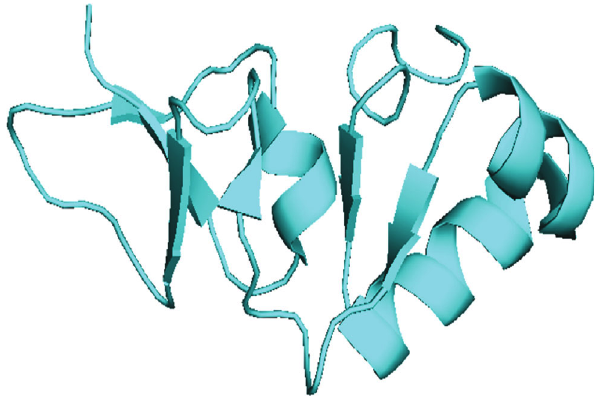
Figure 6: Big defensin solution structure of Tachypleus tridentatus (pdb id: 2RNG)